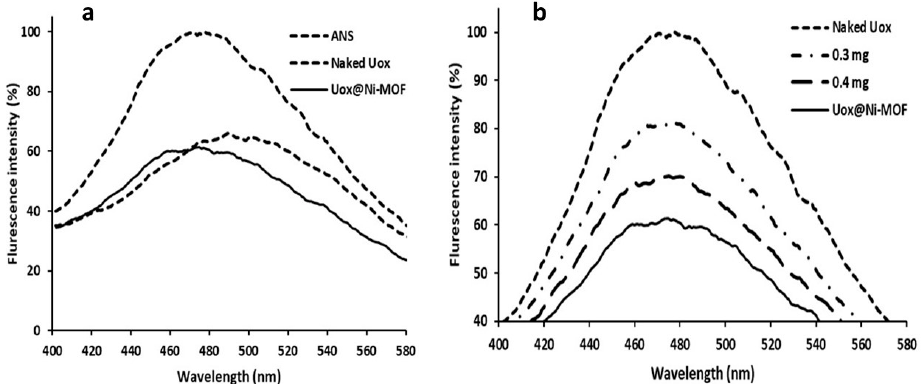
Figure 14. The hydrophobicity of the immobilized enzyme in the presence of ANS. ( a ) fluorescence intensity increased after the connection of ANS to hydrophobic regions, ( b ) depicts changes in the fluorescence intensity of the enzyme in the presence of different NimMOF